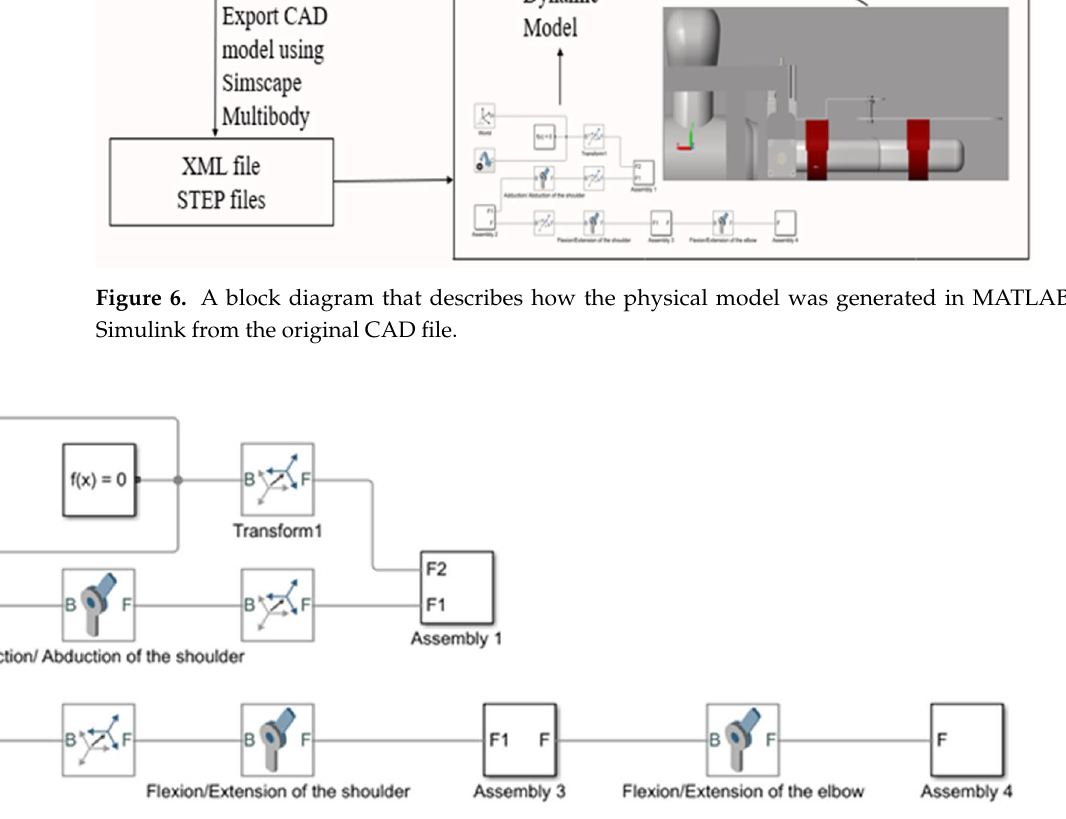
Figure 7. Dynamic physical model of SAMA exoskeleton.